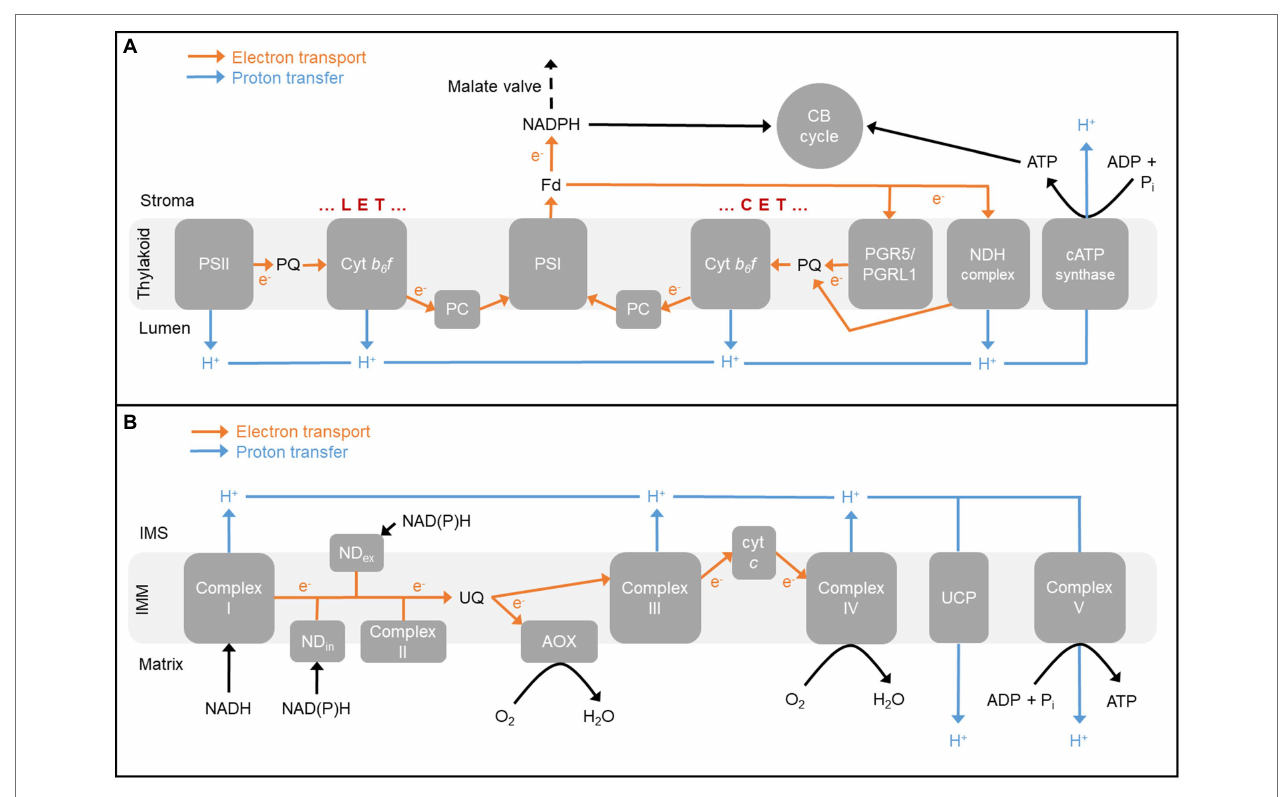
FIGURE 1 | (A) The photosynthetic electron transport chain in chloroplast thylakoid membrane. Linear electron transport (LET) involves both photosystems while cyclic electron transport (CET) involves only photosystem I (PSI). Both modes of electron transport contribute to the proton motive force used by chloroplast ATP synthase (cATP synthase) to generate ATP, while only LET contributes to NADPH production. ATP and NADPH support carbon fixation by the Calvin-Benson (CB) cycle. One pathway of CET involves the proton-pumping NADH dehydrogenase-like (NDH) complex, while the other pathway involves the proteins PROTON GRADIENT REGULATION5 (PGR5) and PGR5-LIKE PHOTOSYNTHETIC PHENOTYPE1 (PGRL1). The malate valve can transfer NADPH equivalents from the stroma to cytosol. (B) The respiratory electron transport chain in inner mitochondrial membrane (IMM). Complex I, a family of other internal and external alternative dehydrogenases (ND in and ND ex , respectively), and Complex II oxidize reducing equivalents. Electrons partition between the cytochrome (cyt) pathway [involving Complex III, cyt c , and Complex IV (cyt c oxidase)] and alternative oxidase (AOX). The proton motive force generated by electron transport is used by the mitochondrial ATP synthase (Complex V) to generate ATP. The proton gradient can also be dissipated by uncoupling proteins (UCP). Electron flow from reducing equivalents to cyt c oxidase is more tightly coupled to the generation of proton motive force (2–3 sites of proton translocation) than is electron flow from reducing equivalents to AOX (0–1 sites of proton translocation). Fd, ferredoxin; IMS, intermembrane space; and PC,